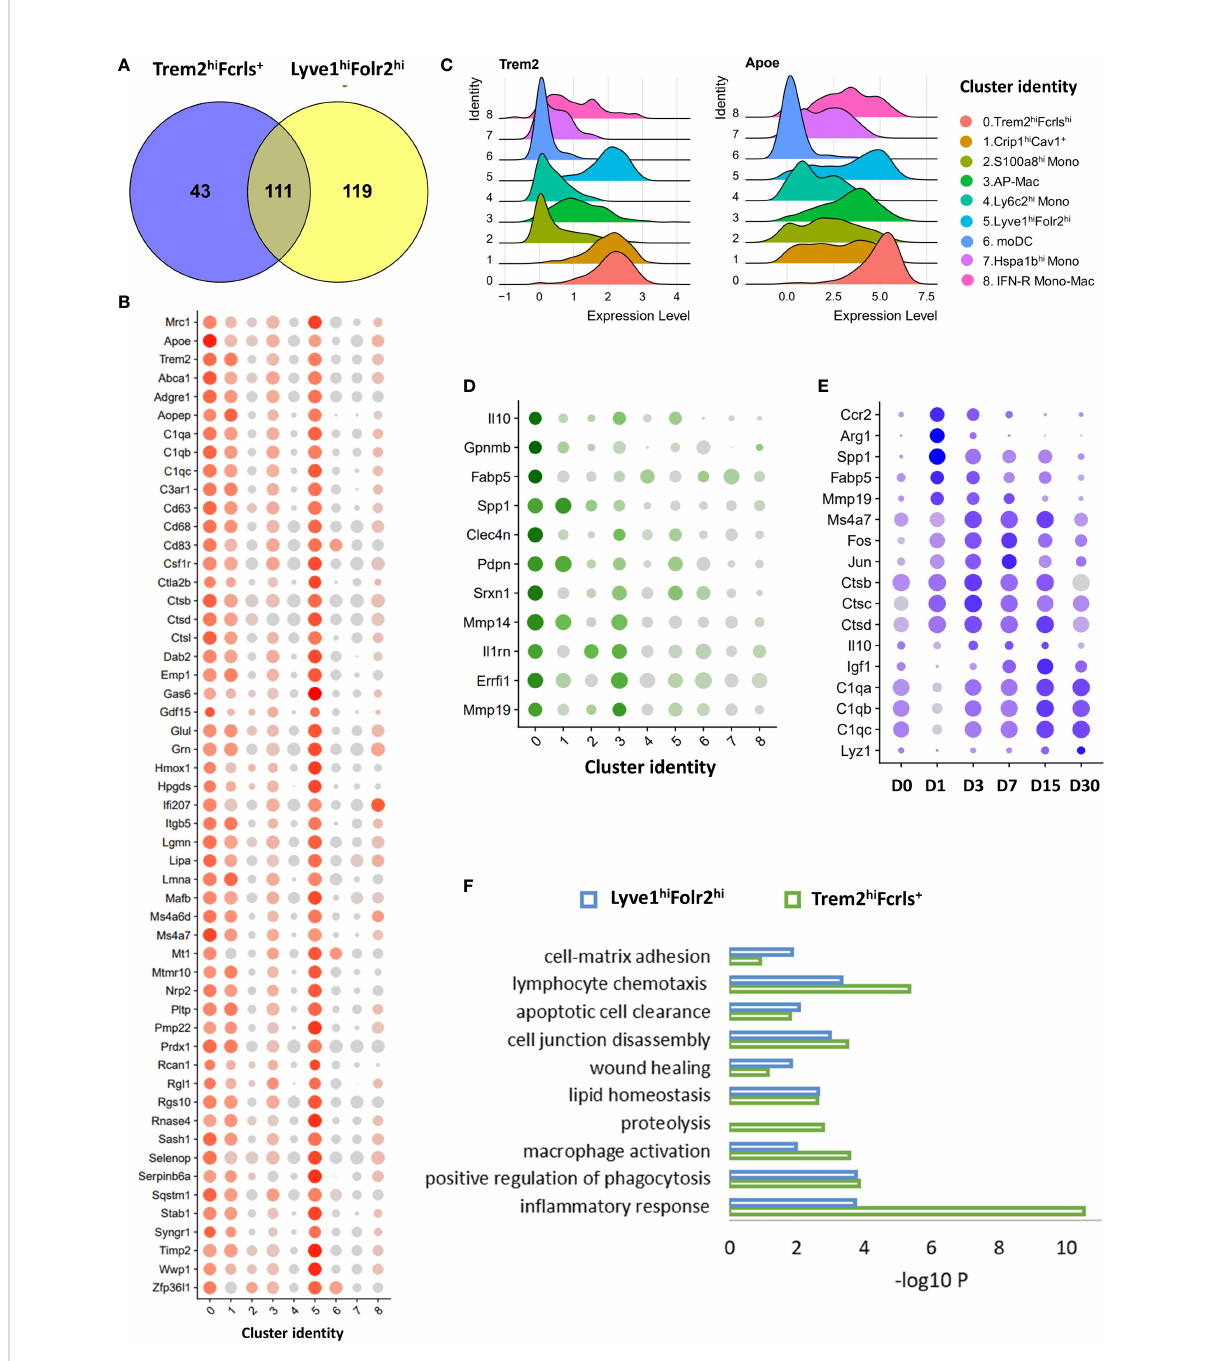
FIGURE 6 Characterization of Trem2 hi M2-like macrophages using scRNA-seq. (A) Venn diagrams showing the overlap between genes enriched in both Trem2 hi Fcrls + and Lyve1 hi Folr2 hi macrophages compared to all other clusters. (B) Dot plot showing the expression of a subset of genes enriched in both Trem2 hi Fcrls + and Lyve1 hi Folr2 hi macrophages. Dot size represents the fraction of cells expressing each gene (grey: low expression; red: high expression). (C) Ridge plot showing the expression of Trem2 and its ligand Apoe in various clusters. Both Trem2 and Apoe were enriched in Trem2 hi Fcrls + and Lyve1 hi Folr2 hi macrophages. (D) Dot plot showing the expression of a subset of genes enriched in Trem2 hi Fcrls + macrophages compared to Lyve1 hi Folr2 hi macrophages. Dot size represents the fraction of cells expressing each gene (grey: low expression; green: high expression) (E) Genes upregulated in Trem2 hi Fcrls + macrophages after injury. Dot size represents the fraction of cells expressing each gene (grey: low expression; blue: high expression). (F) Ontology terms associated with genes enriched in Trem2 hi Fcrls + and Lyve1 hi Folr2 hi macrophages compared to other